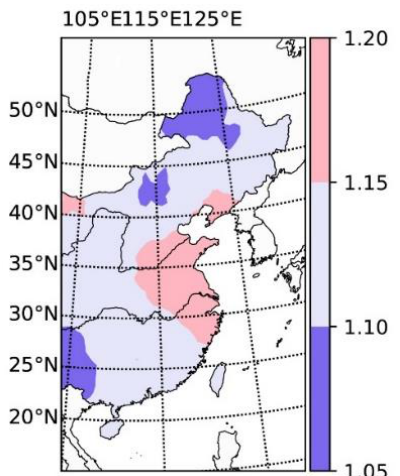
Figure 6. Spatial distribution of the power-law distribution means exponent β of precipitation quiet time in eastern China.